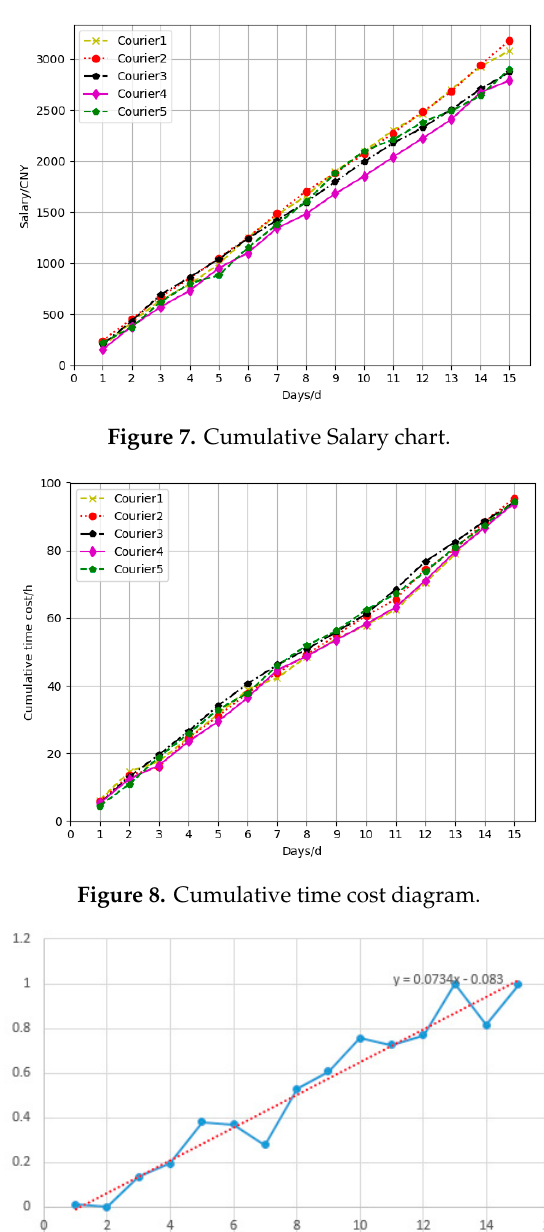
Figure 10. Standard deviation chart.